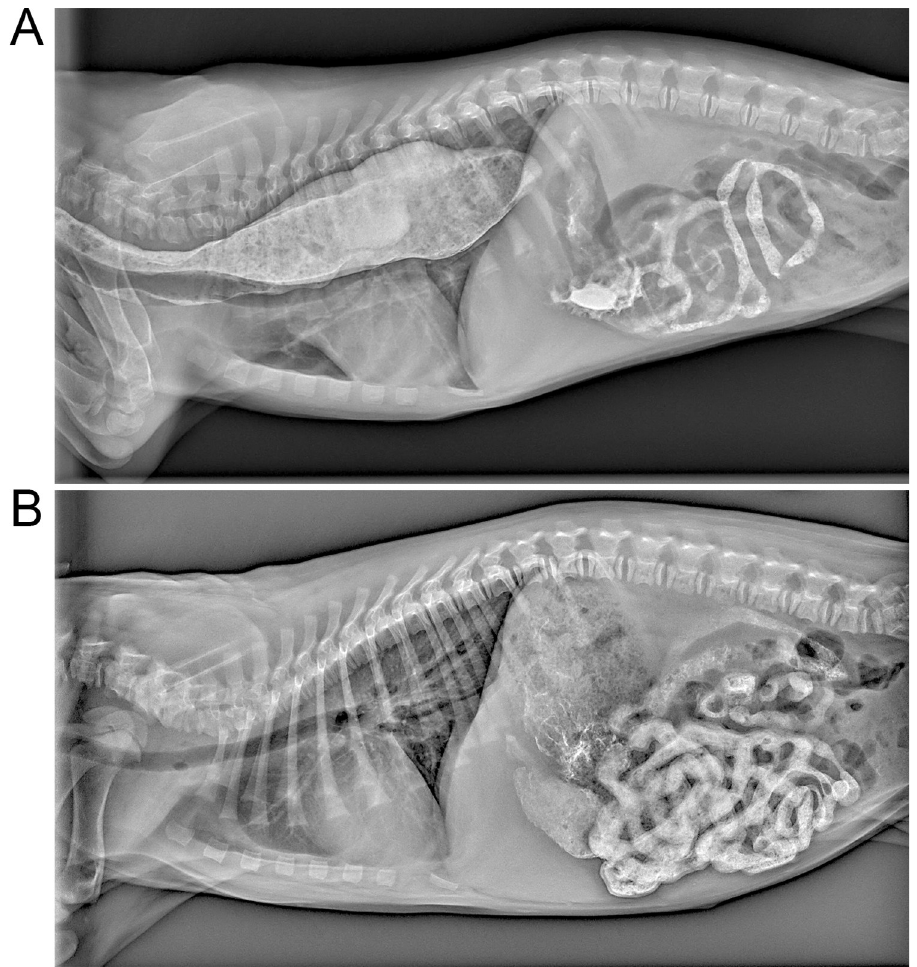
Fig 1. Barium-contrast radiographs of affected and healthy puppies. Radiographs were taken 40 minutes after a barium meal in five-week old puppies. A) Barium coats the enlarged esophagus of a CIM-affected GSD and (B) passes through to the stomach and intestines in a healthy